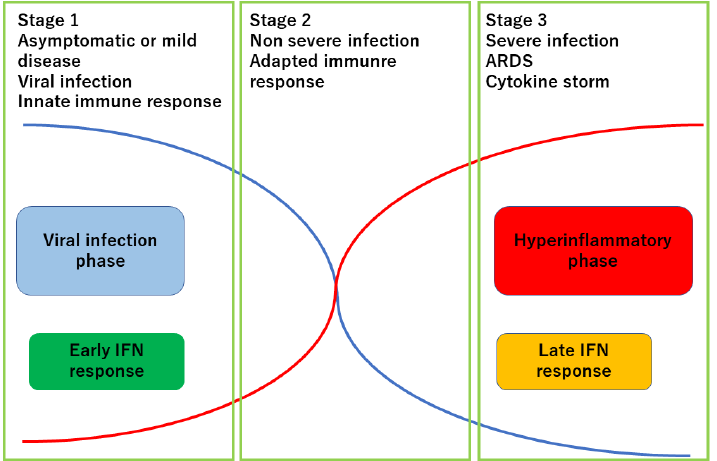
Figure 1. Three stages of COVID-19 infection. Modified from reference [8].